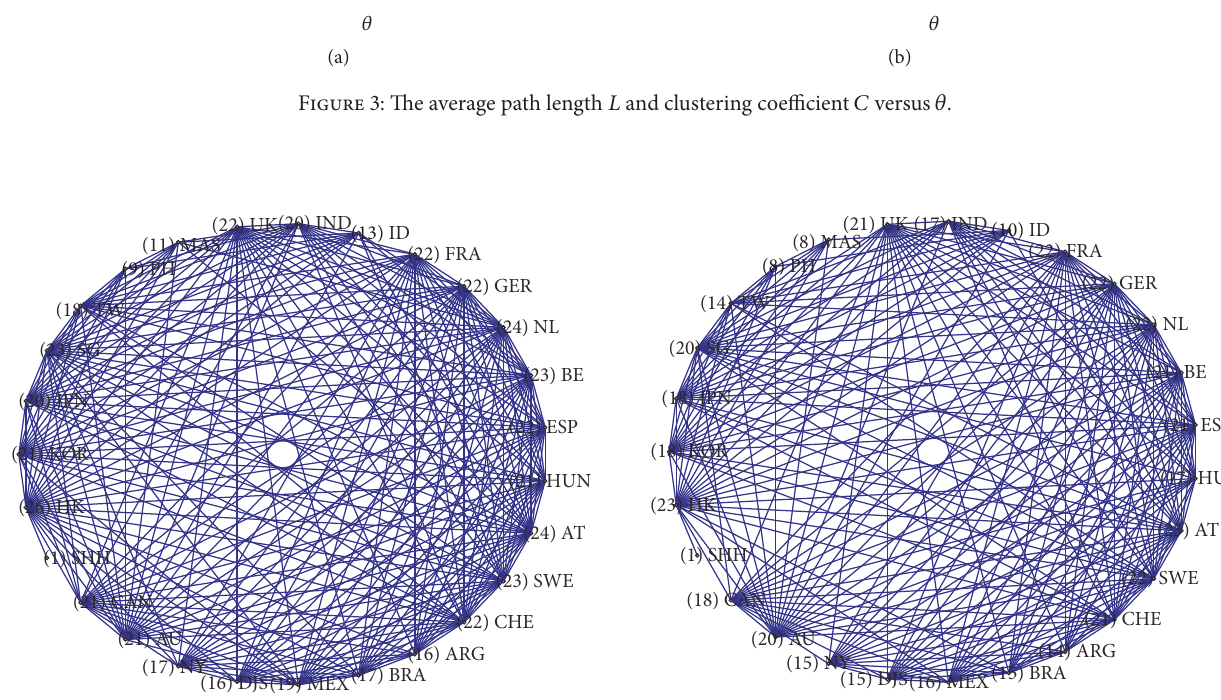
Figure 4: Topology graph of ISMN at 𝜃 = 0.25 . Figure 5: Topology graph of ISMN at 𝜃 = 0.3